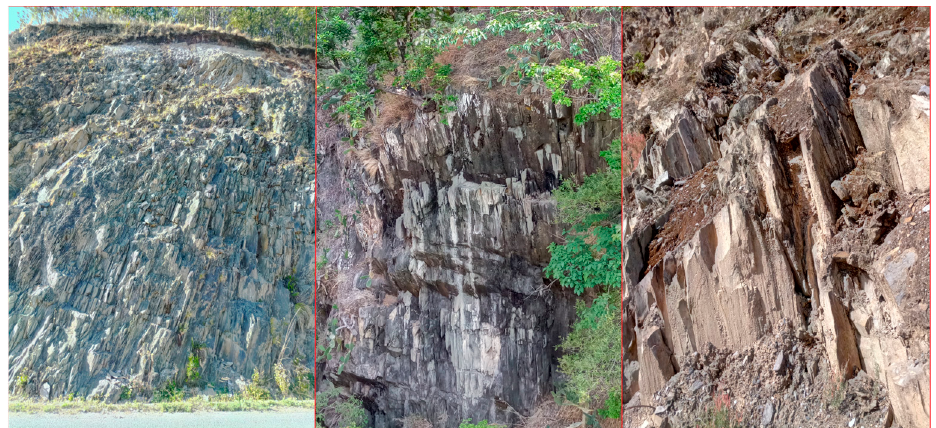
Figure 2. Exposed rocks of reservoir bank slopes in Miaowei reservoir area.